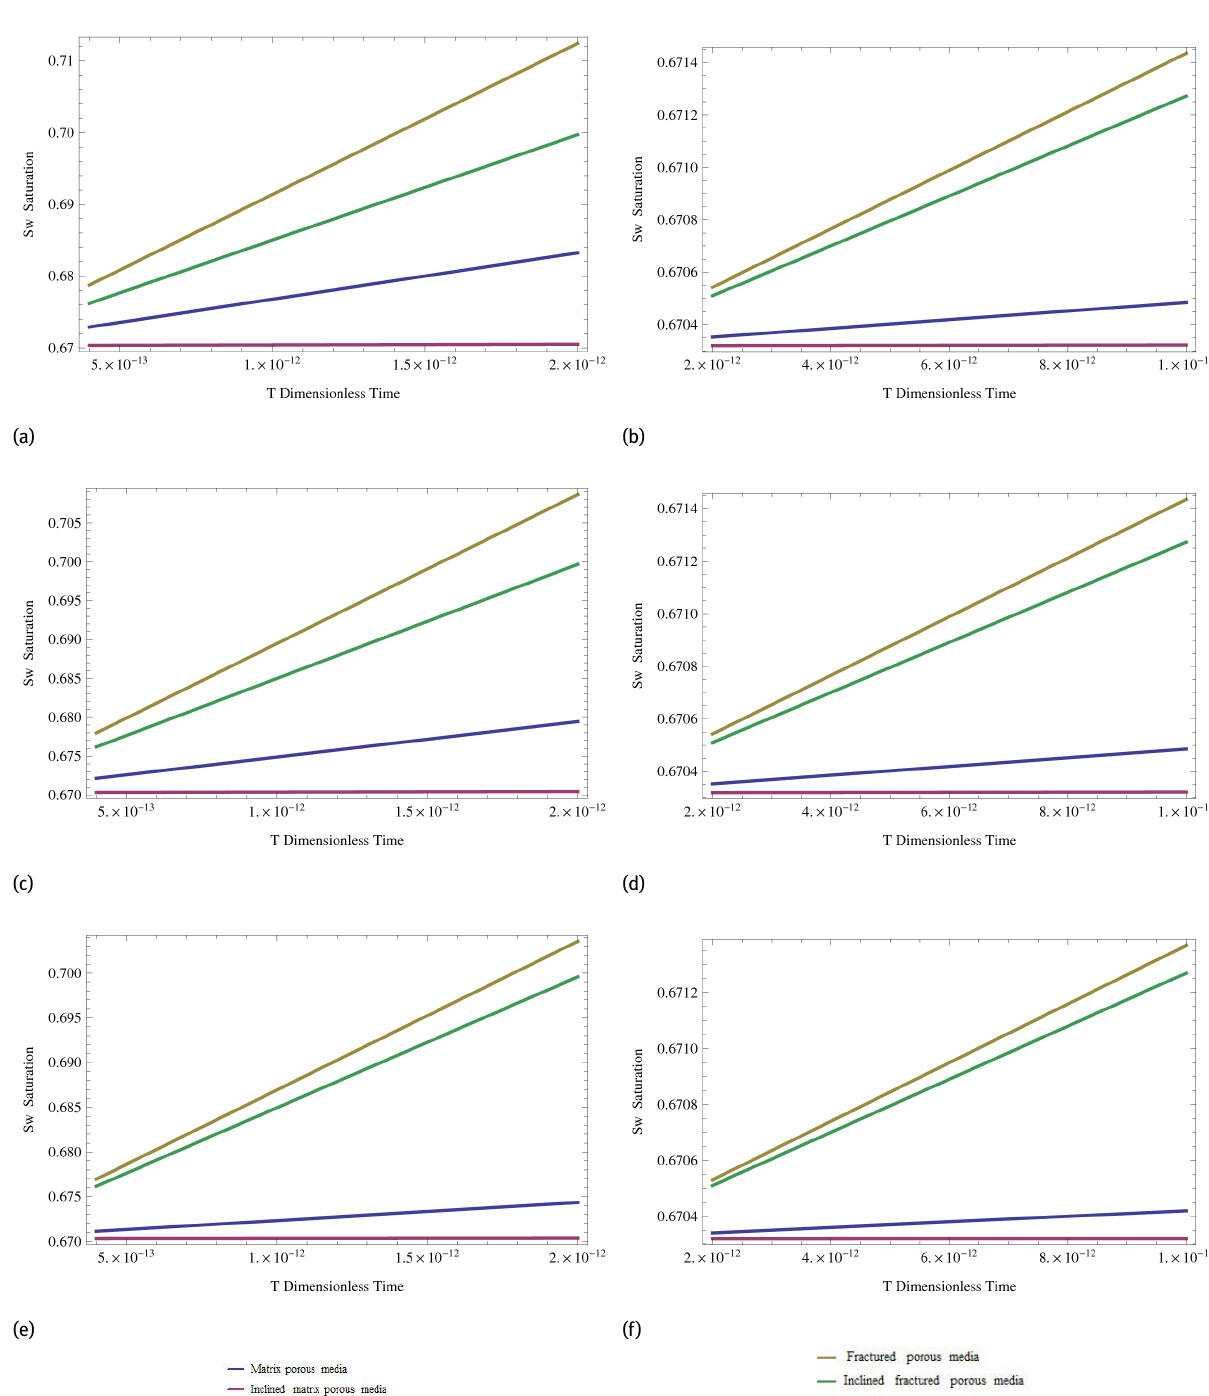
Fig. 4: Satuartion rate for Fine Sand (a)with magnetic field effect (b) without magnetic field effect,Satuartion rate for Volcanic Sand (c)with magnetic field effect (d) without magnetic field effect,Satuartion rate for Glass beads (e)with magnetic field effect (f) without magnetic field